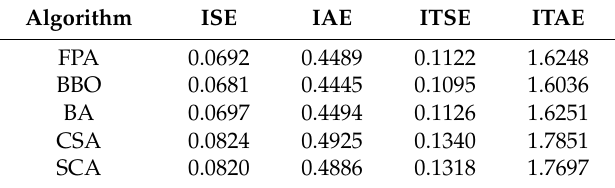
Table 5. Performance indices of PI controllers tuned using BA, BBO, CSA, FPA and SCA in case 1.